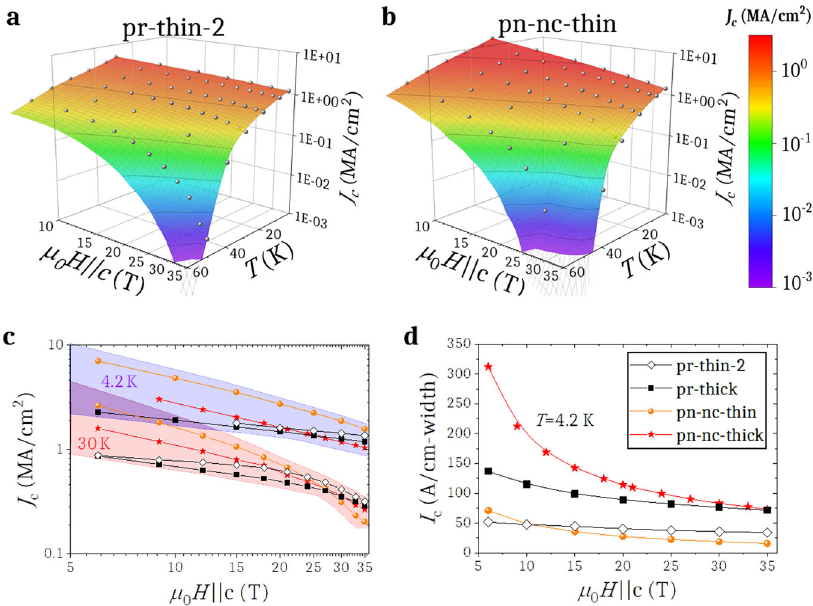
Fig. 6 J c ( H , T ) surfaces, J c ( H ) and I c ( H ) at very high magnetic fi elds for H | | c. J c ( H , T ) surfaces for ( a ) pr-thin-2 and ( b ) pn-nc-thin. Magnetic fi eld dependence of ( c ) J c at 4.2 K (blue region) and 30 K (red region) and of ( d ) I c at 4.2 K for pr-thin-2, pr-thick, pn-nc-thin and pn-nc-thick